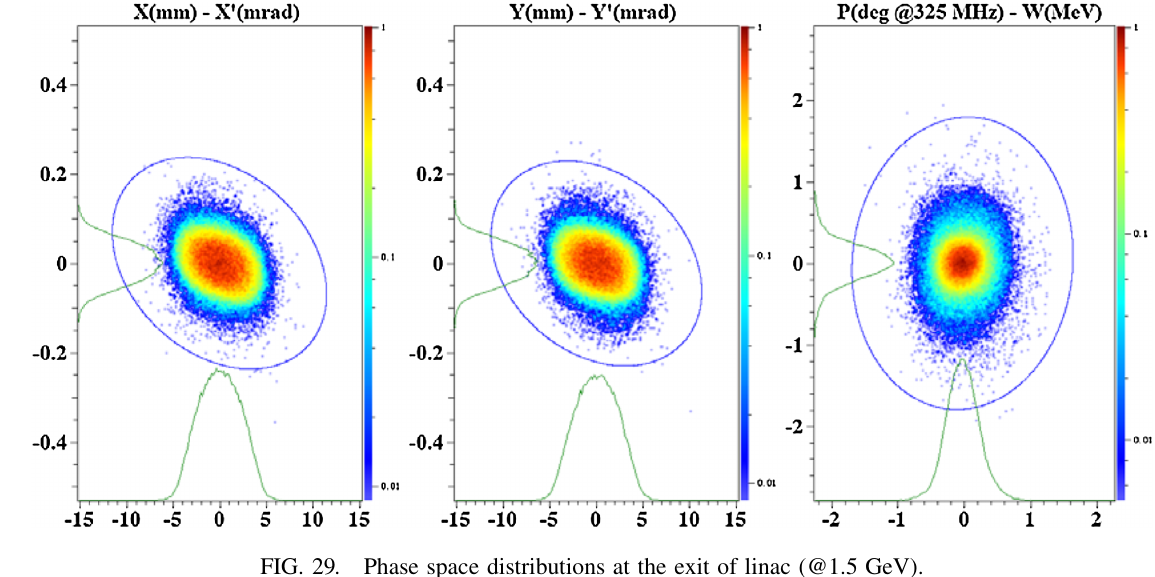
FIG. 29. Phase space distributions at the exit of linac (@1.5 GeV).